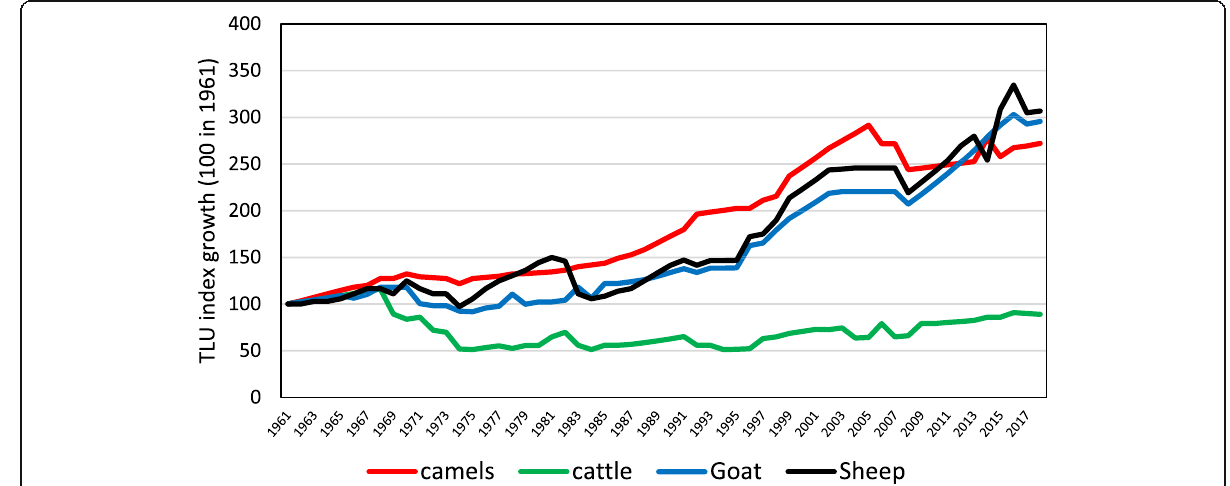
Fig. 3 Change of tropical livestock unit (TLU) index for different farm species in Mauritania between 1961 and 2018 (source FAOstat)